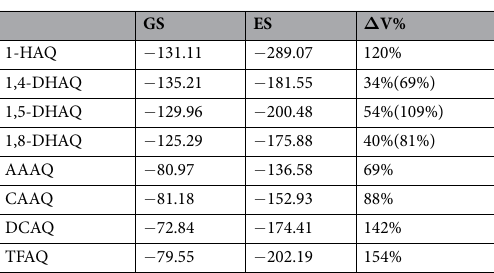
Table 4. Potential energy density V(r) at BCP